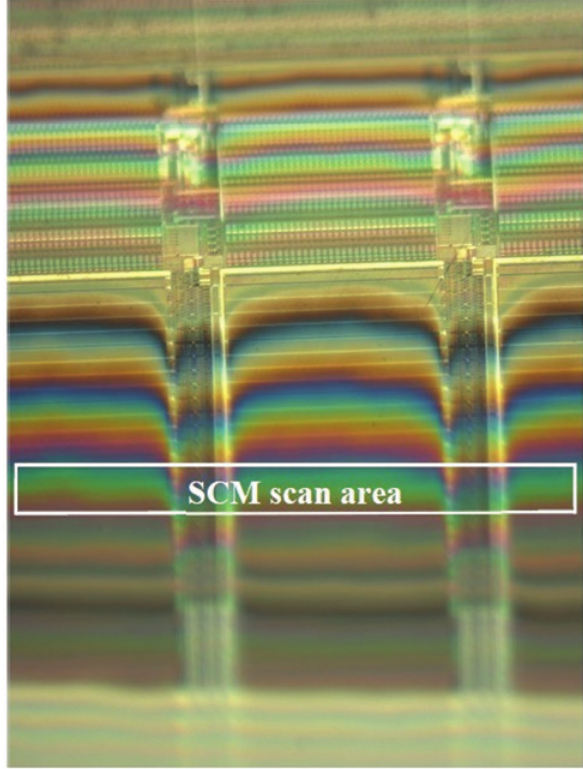
Figure 14: An optical microscope image of the final prepared sample, which is ready for SCM scanning on the backside, showing the thin silicon layer in a bevel pattern.